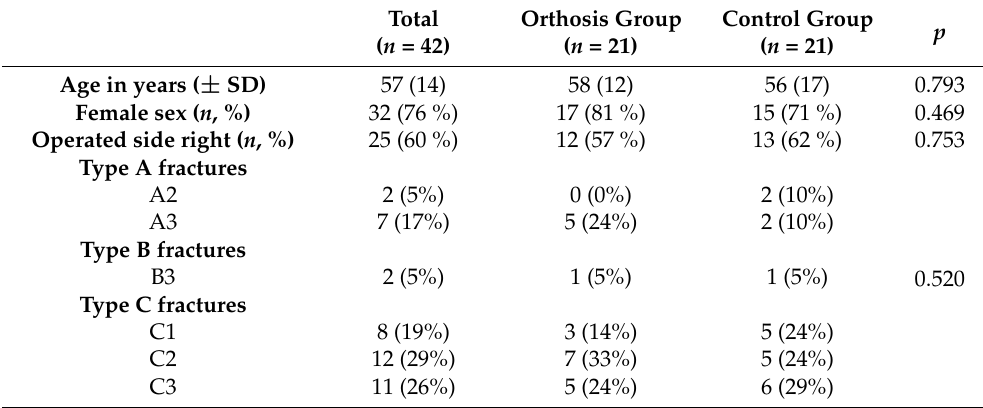
Table 1. Subject characteristics. Independent t -test (age) and Chi-square test (sex, operated side, type of fractures) were used to test if both groups—OG and CG—differed initially.